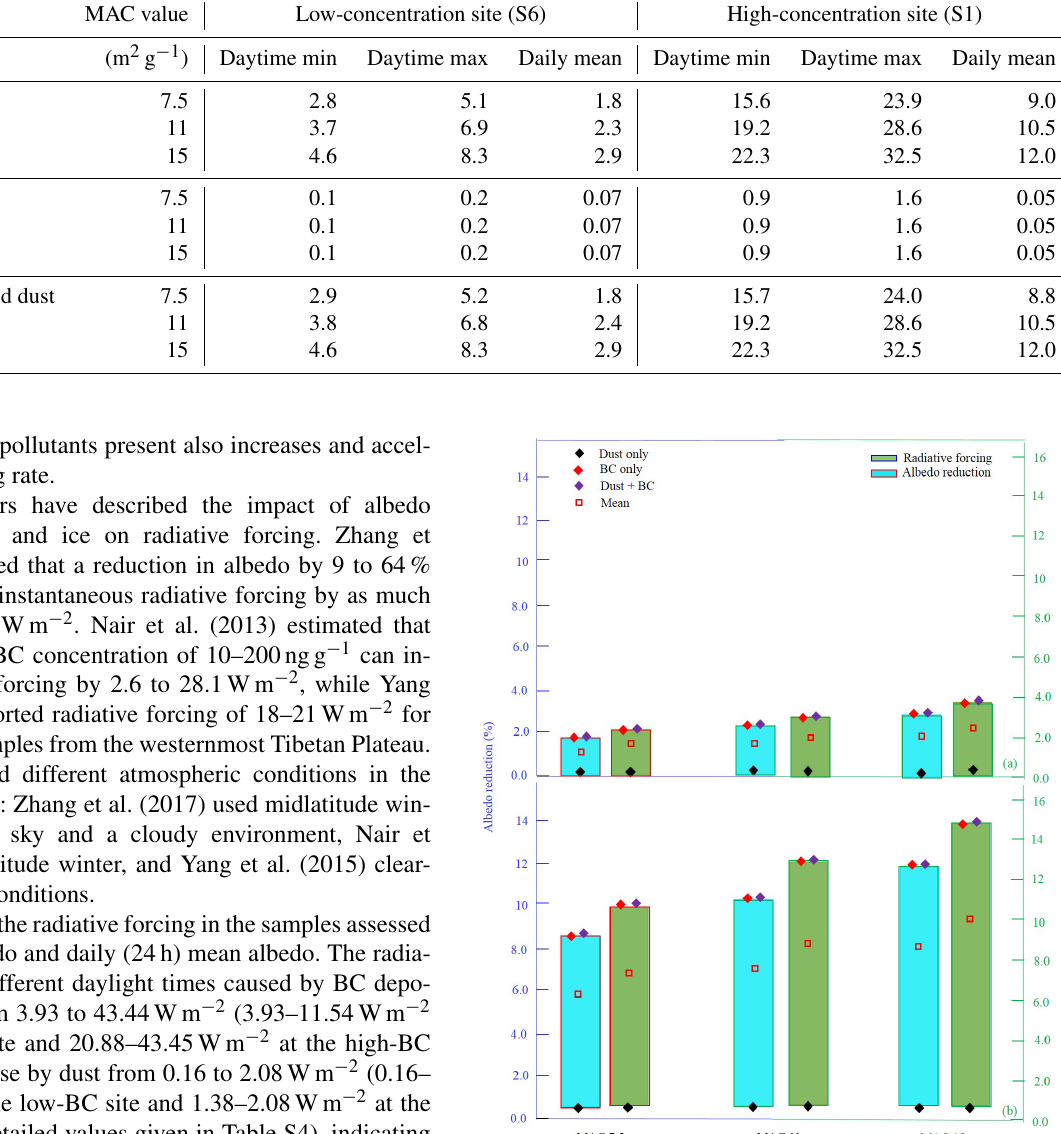
Table 2. Snow albedo reduction (%) by black carbon, dust, and black carbon plus dust at the site with the lowest average pollutant concen- tration (S6) and the site with the highest average pollutant concentration (S1) under different mass absorption cross-section (MAC) values. Pollutant MAC value Low-concentration site (S6) High-concentration site (S1) (m 2 g − 1 ) Daytime min Daytime max Daily mean Daytime min Daytime max Daily mean Black carbon 7.5 2.8